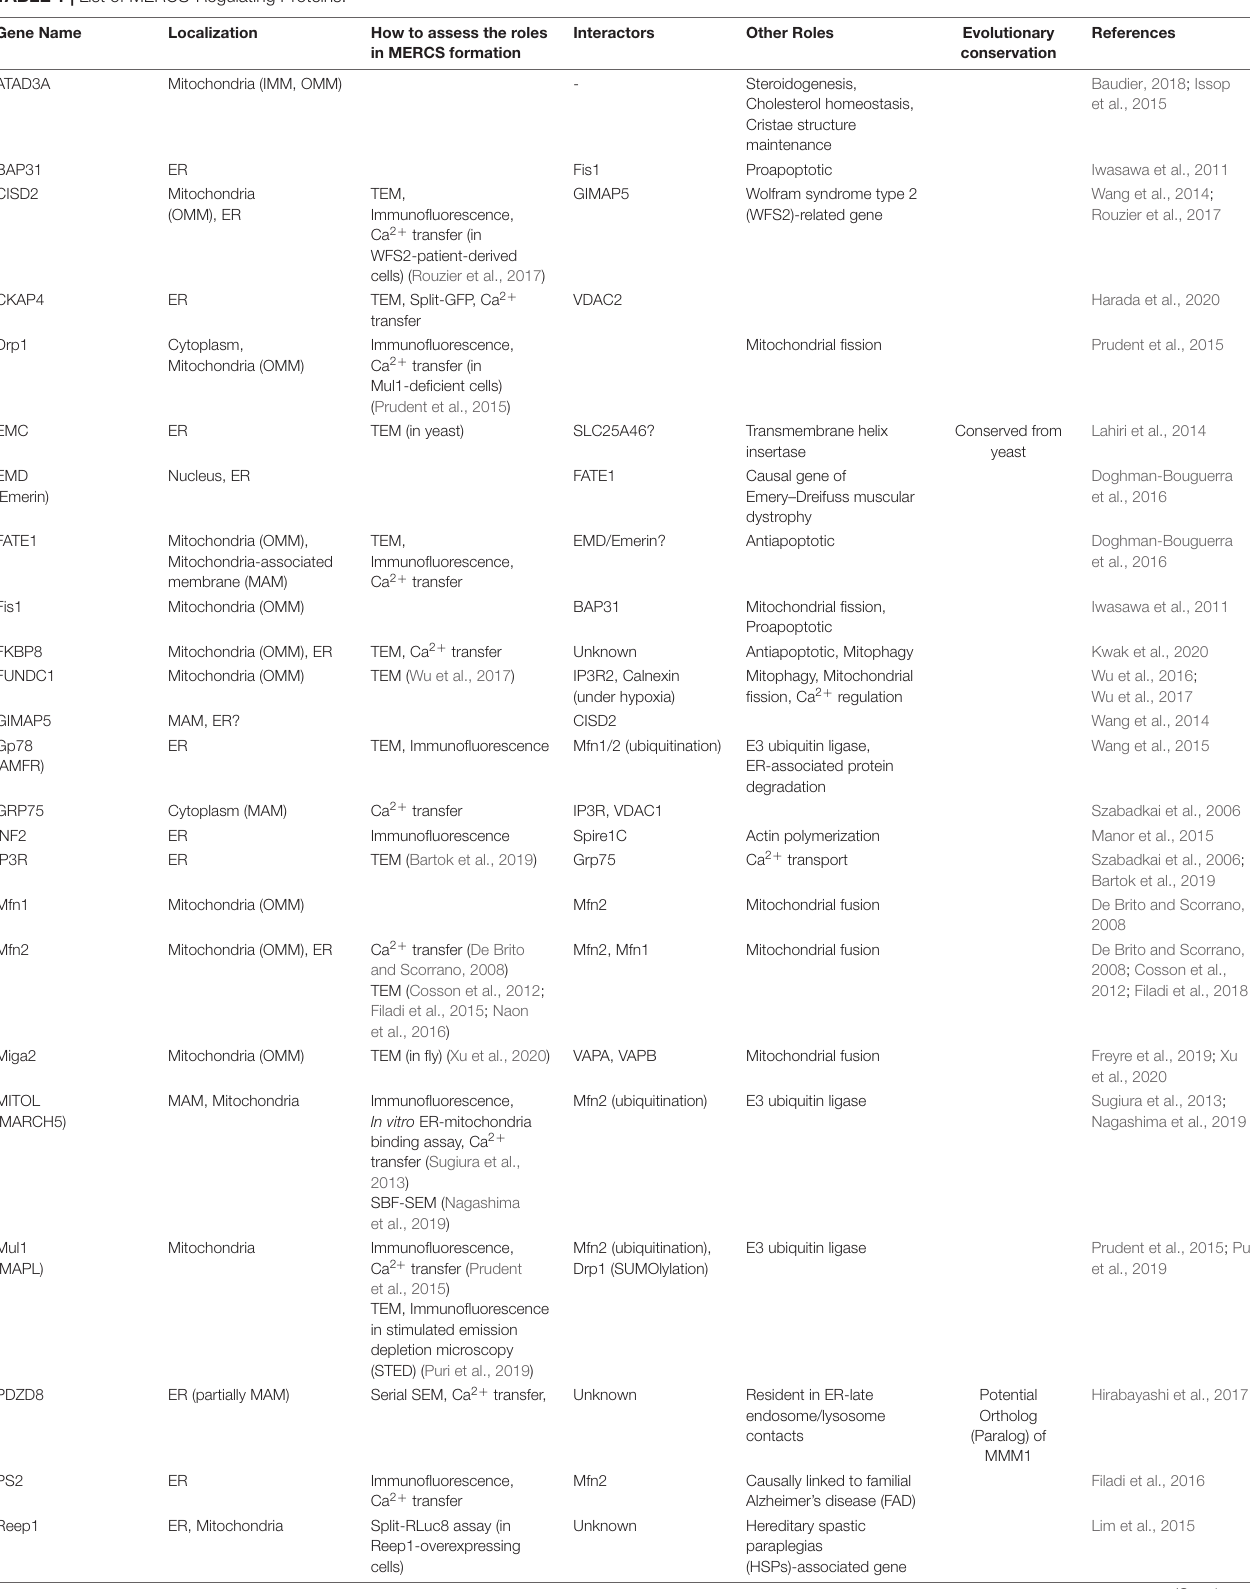
TABLE 1 | List of MERCS-Regulating